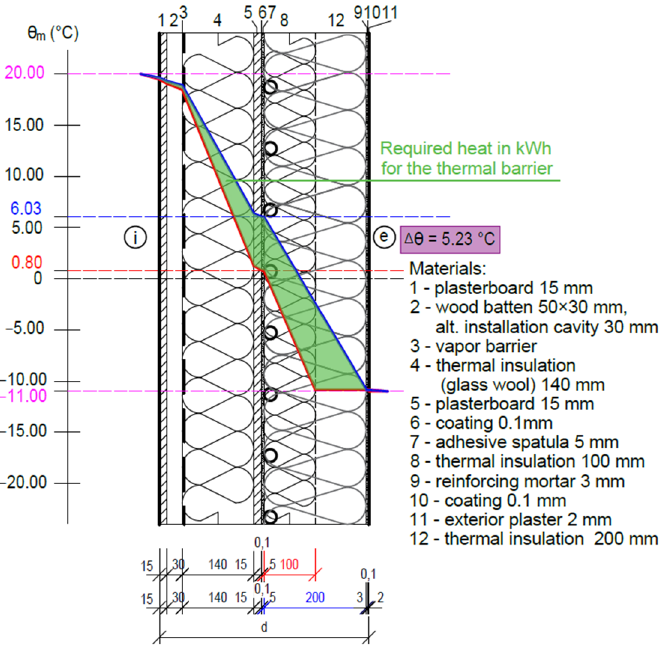
Figure 34. Required heat in kWh delivered by the heat transfer medium to the ATP (TB function) to increase the DTR corresponding to a thermal insulation thickness of 200 mm for a static thermal insu- lation thickness of 100 mm. θ m —the temperature in construction ( ◦ C), ∆ θ —temperature difference ( ◦ C), d—construction thickness (mm), e—exterior, and